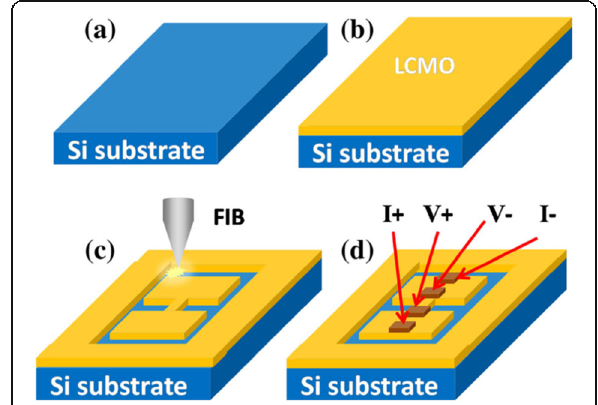
Fig. 15 Schematic diagram for fabrication process of the La 0.67 Ca 0.33 MnO 3 (LCMO) nanobridges. a Substrate, b LCMO film deposition, c nanobridge fabrication by FIB, and d four-electrode test configure. Reproduced with permission of [187]